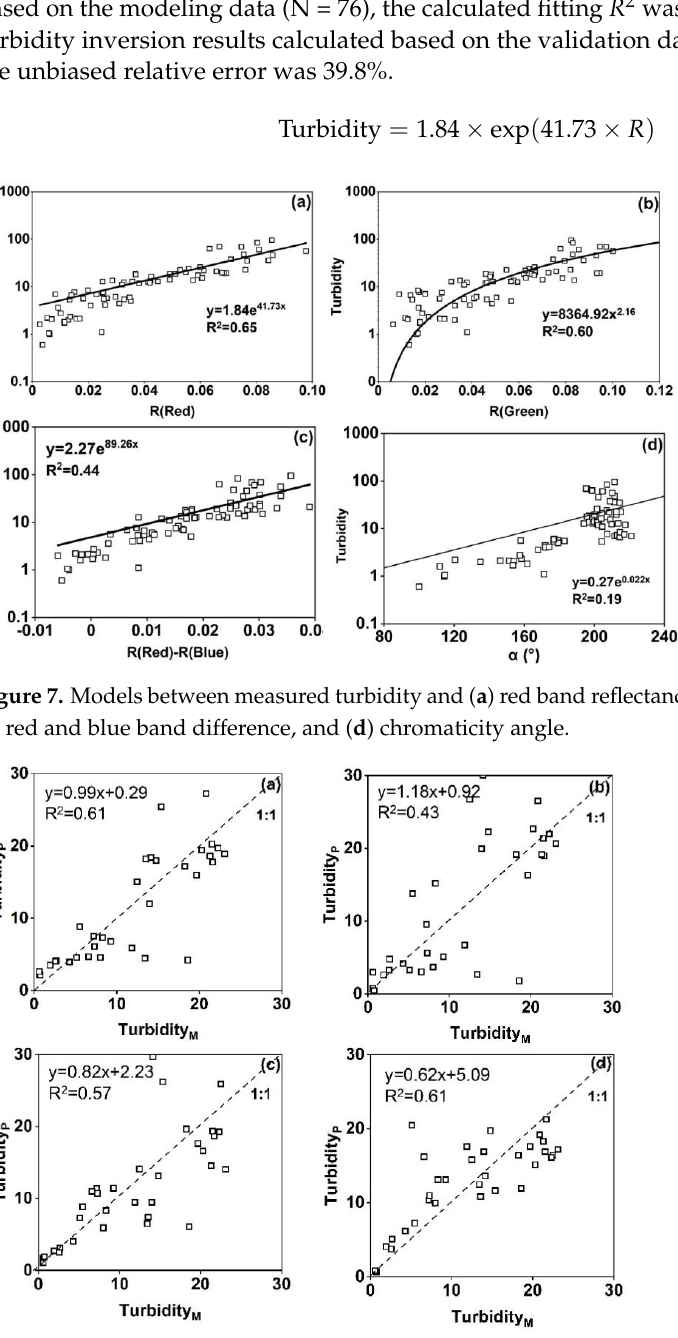
Figure 8. Scatterplots of measured turbidity and model estimated turbidity using ( a ) red band reflectance, ( b ) green band reflectance, ( c ) red and blue band difference, and ( d ) chromaticity angle. Table 6. Turbidity model accuracy test.